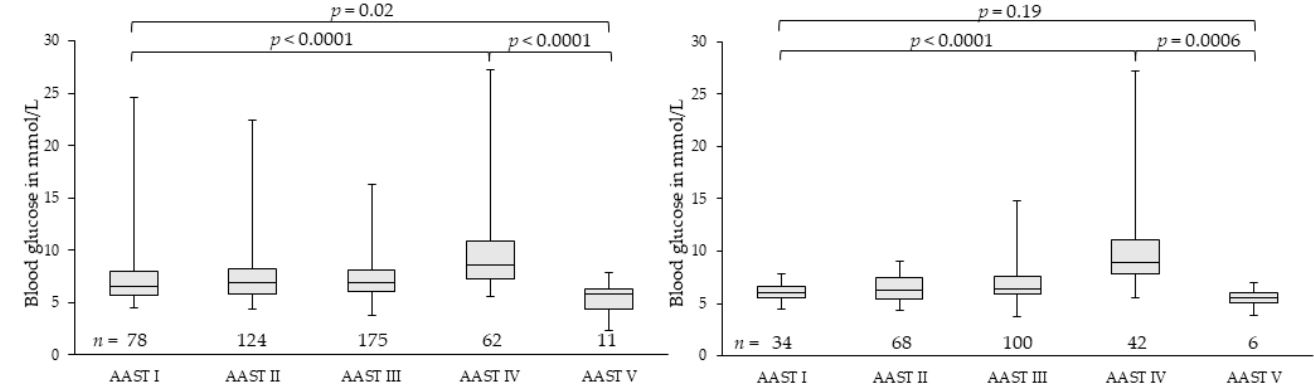
Figure 2. Rising blood glucose levels in parallel to severity of liver injury with lowest blood glucose levels in patients with most severe liver injury (AAST V). Outliers of high blood glucose levels in less severe injuries (AAST I–III) were found in patients with diabetes mellitus disease or severe co-injuries (AIS 4–6) ( a – c ). In patients without severe co-injuries and without diabetes mellitus ( d ), the effect of injury severity and hemorrhage on blood glucose levels was demonstrated, meaning the greater the severity of injury and the hemorrhage extent, the higher the stress hyperglycemia. In patients with most severe liver injury (AAST V), stress hyperglycemia is absent. AAST: American Association for the Surgery of Trauma [27,28]; AIS: Abbreviated Injury Scale [43]. Table 3. Blood glucose levels in mmol/L for liver, spleen and kidney injuries as function of injury severity with and without co-injuries AIS 4–6 and diabetes mellitus.